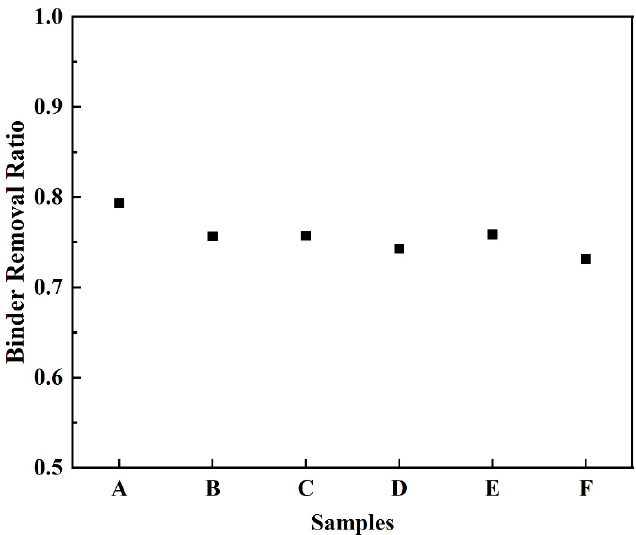
Figure 5. Binder removal ratios of green parts (sample A–F) after solvent debinding for 8 h.